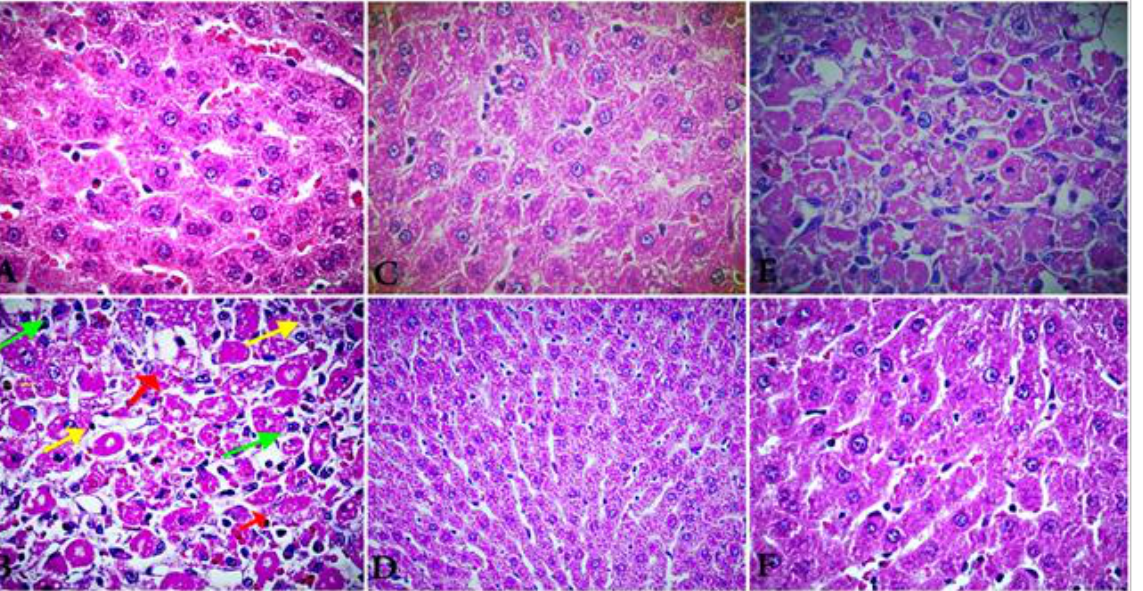
Figure 4. A representative photomicrograph of a section of the liver tissues of rats exposed to CCL 4 (1.25 mg/kg BW) for 15 days, followed by silymarin (10 mg/kg BW) and extracted EO at two doses (5 and 10 mg/kg BW) for 15 days (E&F). Control rats (( A ), 100 µ m) show a normal architecture of hepatocytes and intact cell membrane. (( B ), 100 µ m) section of liver of rats treated by CCL 4 shows altered hepatocyte morphology, with loss of cell membrane, increased nuclear size, and connective tissue infiltration with prominent necrosis and vacuoles. (( C ), 100 µ m) section of liver of rat’s vehicle-treated control exhibits normal architecture hepatocytes, intact cell membrane, and central vein. (( D ), 100 µ m) section of liver of rats treated by CCL 4 (1.25 mg/kg BW) for 15 days and followed by silymarin for the next 15 days exhibits potent hepatoprotective activity with radially arranged hepatocytes similar to the control with intact cell membrane, as well as infiltration of cells formation of normal hepatic cards and absence of necrosis and vacuoles. (( E ) , 100 μm) section of liver of rats treated by CCL 4 (1.25 mg/kg BW) and followed by extracted EO (5 mg/kg BW) ex- hibits moderate hepato-therapeutic activity with radially arranged hepatocytes similar to the con- trol with intact cell membrane and infiltration of cells. (( F ), 100 μm) section of liver of rats treated by CCL 4 (1.25 mg/kg BW) and followed by extracted EO (10 mg/kg BW) exhibits highly hepato-